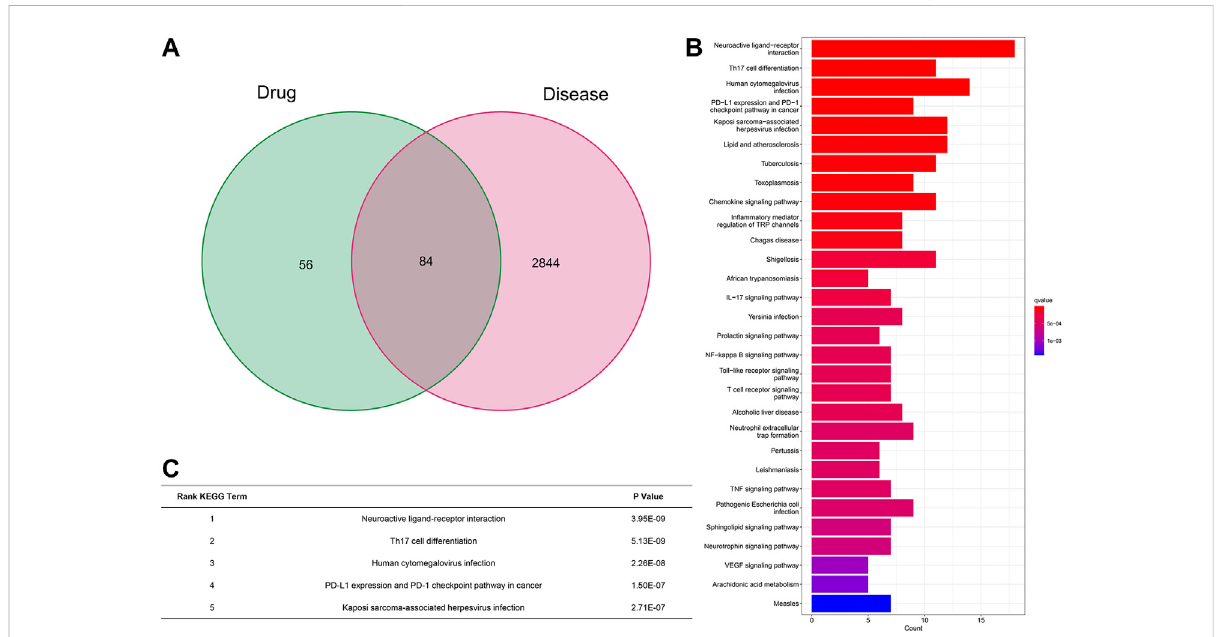
FIGURE 2 KEGGpathway analysisoflicorice among 84genesets. (A) Summaryofsigni fi cant, differentially expressed genes. (B) KEGGpathway analysisof the 84 genes differentially targeted by licorice related to in fl ammation. (C) Most important interaction between licorice and in fl ammation according to KEGG pathway